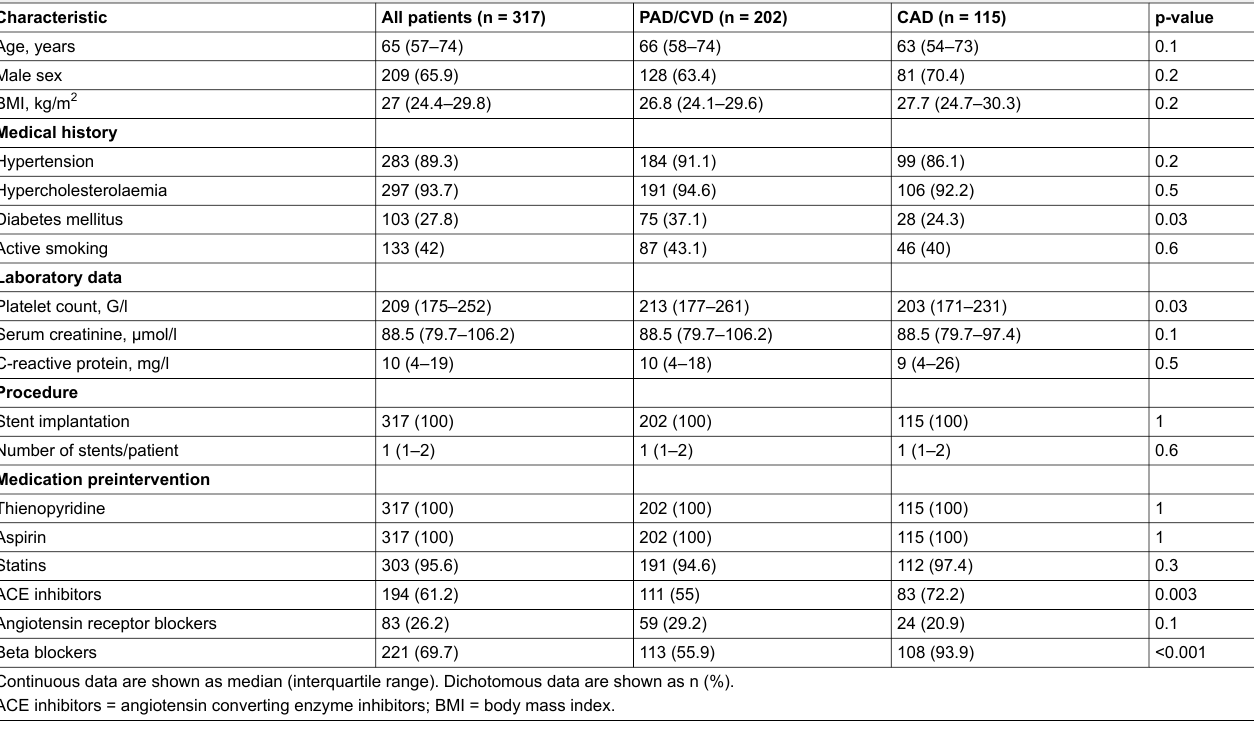
Table 1: Clinical, laboratory and procedural characteristics of the overall study population, and of patients with peripheral artery / cerebrovascular disease (PAD/CVD) or coronary artery disease (CAD). Characteristic